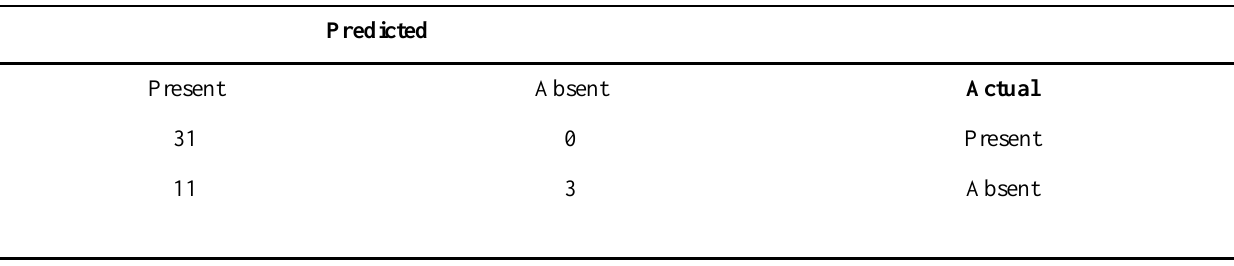
Table 2. Example of a confusion matrix showing the prediction accuracy of the Bayesian belief network (BBN) beta model in Fig. 3a used with the case data file in Table 1. The confusion matrix shows the number of known cases that were correctly classified, here as whether the species was actually present or absent, given the conditions on each